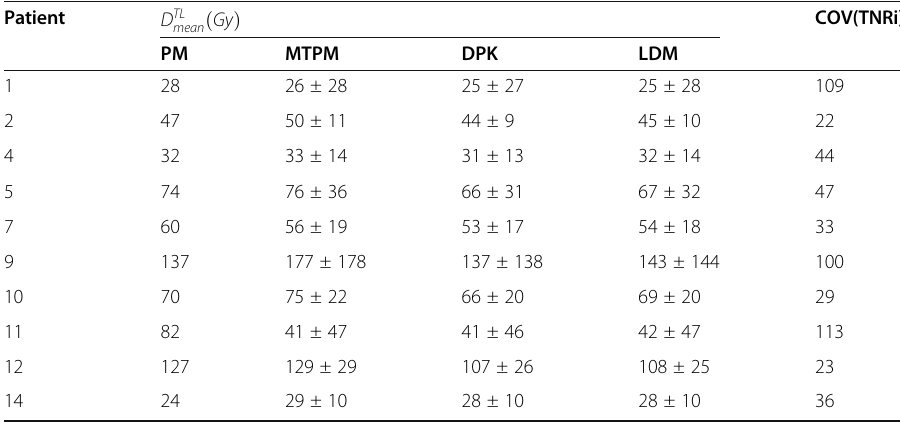
Table 4 Mean absorbed dose delivered to aggregated tumoral liver calculated by means of multicompartmental (PM and MTPM) and 3D voxel dosimetry methods (LDM and DPK), for patients with more than a single lesion. COV(TNR i ) is also reported